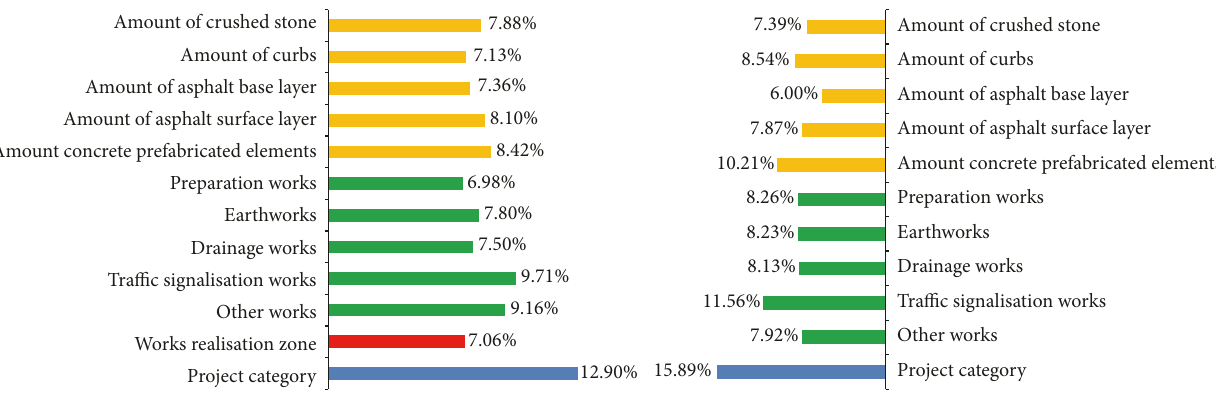
Figure 2: Analysis of sensitivity (ANN 5 and ANN 6); estimation of duration of